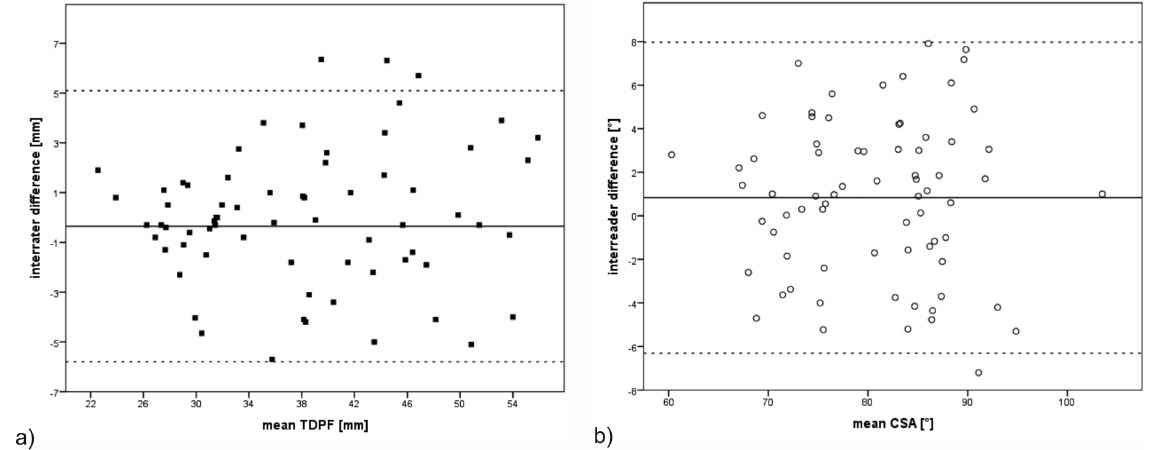
Figure 3. Measurements of the TDPF and CSA by two readers. a) Mean TDPF measured by the two readers plotted against the interrater difference. Continuous line represents overall mean difference (0.4 mm). Dashed lines represent 95% confidence intervals. b) Mean CSA measured by the two readers plotted against the interrater difference. Continuous line represents overall mean difference (0.8 u ). Dashed lines represent 95% confidence intervals.